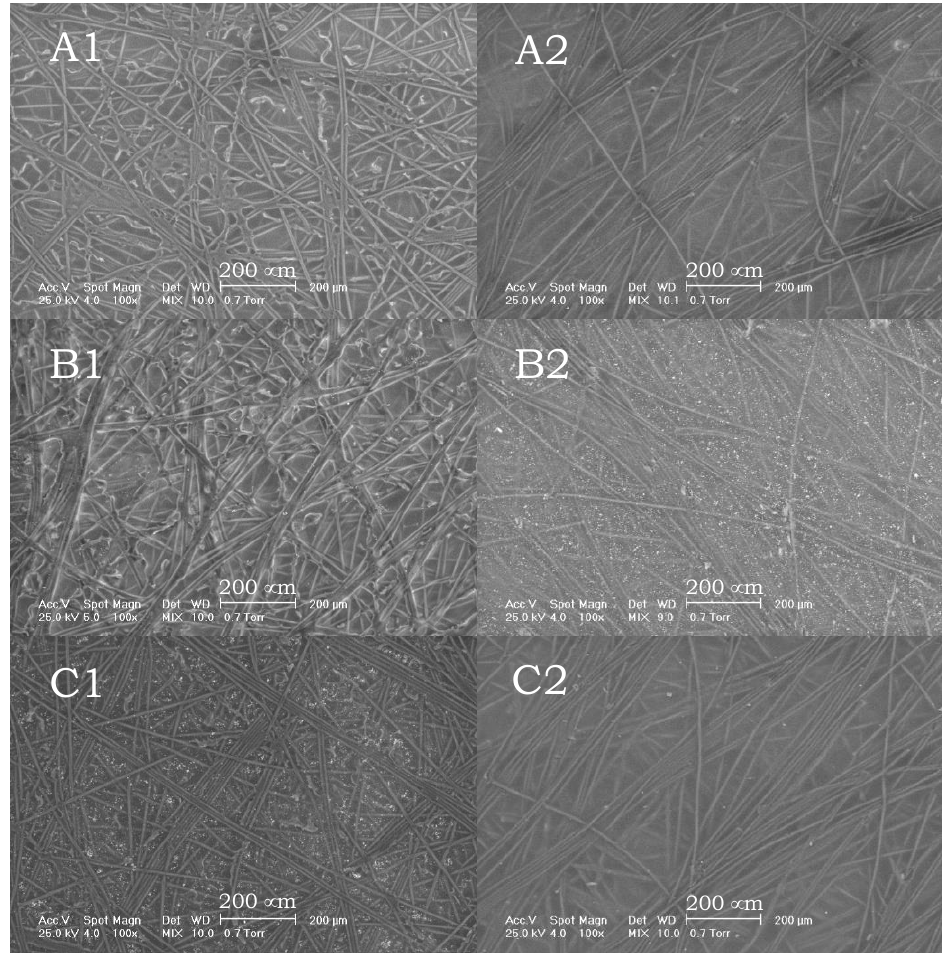
Figure 2. SEM images of active surface for CA neat membrane ( A1 ), CA/APTES/CE membrane ( B1 ), and CA/APTES/CE membrane after Gd (III) filtration ( C1 ) and porous surface for CA neat mem- brane ( A2 ), CA/APTES/CE membrane ( B2 ), and CA/APTES/CE membrane after Gd (III) filtration ( C2 ).